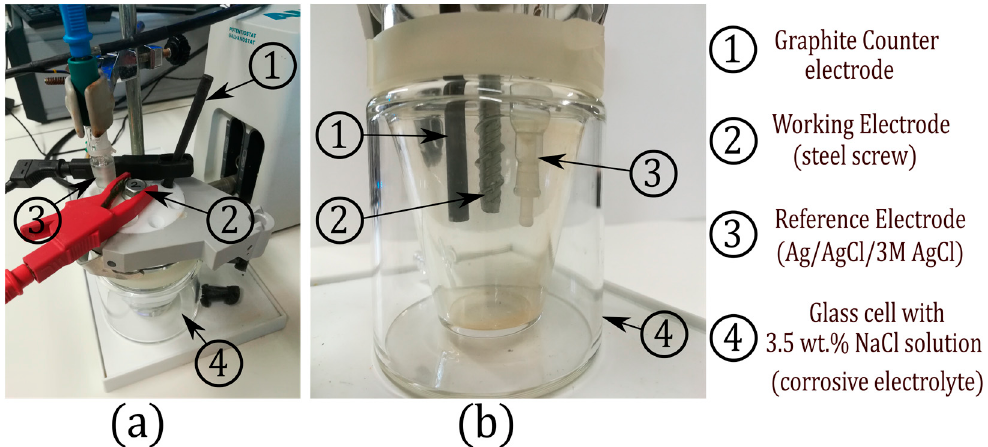
Figure 3. Conventional three-electrode cell used for the electrochemical corrosion tests and the glass cell that contained the corrosive electrolyte (NaCl): ( a ) Connections made to each of the electrodes; ( b ) Placement of each of the electrodes inside the glass cell.